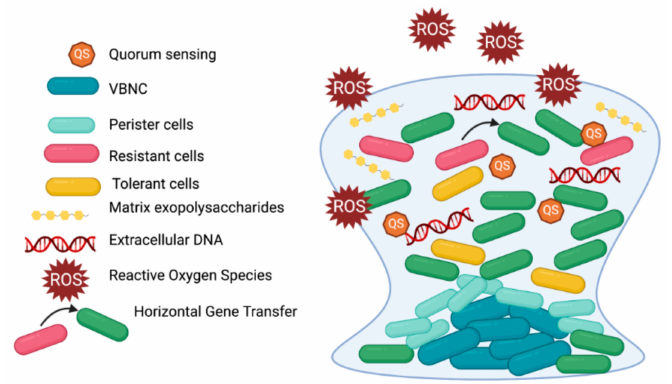
Figure 4. Schematic overview of a mature biofilm structure. Biofilm is characterized by heterogenous environment and the presence of a variety of subpopulations. A biofilm structure is composed of metabolically active (both resistant and tolerant) and non-active cells (viable but not culturable cells, VBNC, and persisters) as well as polymer matrix consisting of polysaccharide, extracellular DNA and proteins. Biofilm growth is associated with an escalated level of mutations and horizontal gene transfer (HGT) which is promoted in due to the packed and dense structure. Bacteria in biofilms communicate by QS, which activates genes participating in virulence factors production (modified from Hall and